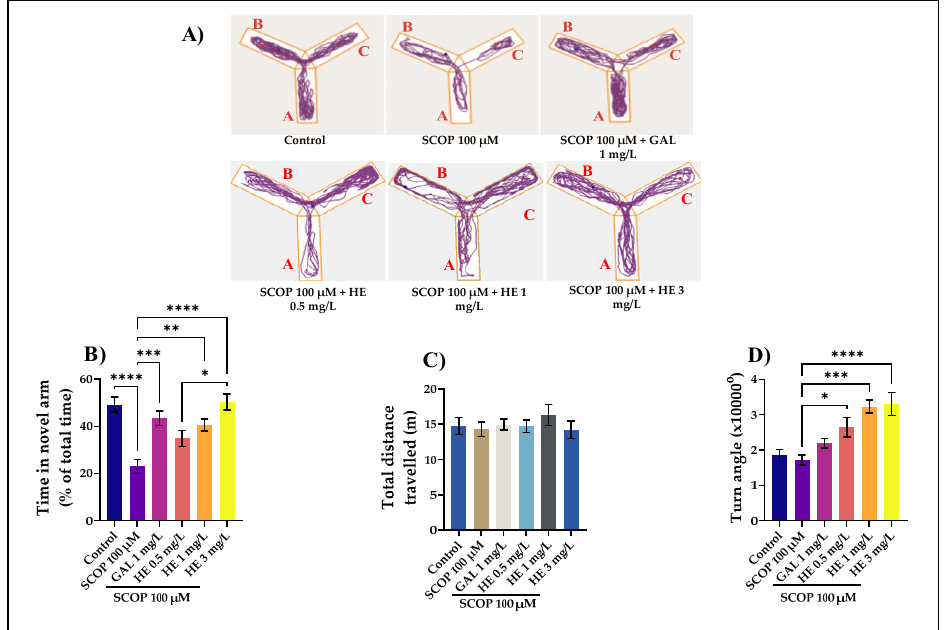
Figure 3. Hericium erinaceus ethanolic extract (HE: 0.5, 1, and 3 mg/L) improved the locomotion pattern and memory in the Y-maze test. ( A ) Representative locomotion-tracking pattern of the control, scopolamine (SCOP: 100 μ M), Hericium erina- ceus (HE: 0.5, 1, and 3 mg/L) and galantamine (GAL: 1 mg/L) treated groups. ( B ) Representation of the total time spent in the novel arm in different groups. ( C ) Representation of the total distance traveled by zebrafish in the tank in different groups. ( D ) Representation of the turn angle of zebrafish in the tank in different groups. Values are means ± S.E.M. (n = 10). For Tukey’s post hoc analyses: **** p < 0.0001, *** p < 0.001, ** p < 0.01, and * p < 0.05.